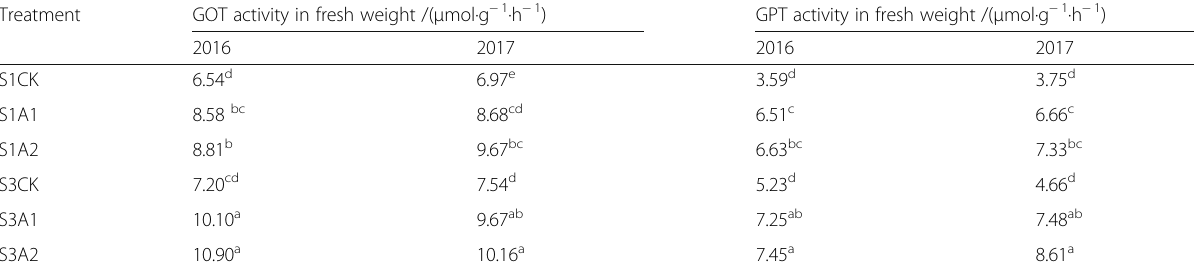
Table 1 The effect of application of 5 amino acids and 21 amino acids on flower GOT and GPT activities of the two Bt cotton cultivars at flowering period